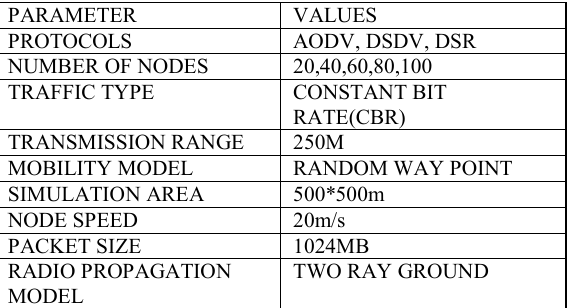
Table7 :- Constant packet size of 1024 Mb with variable number of nodes No of